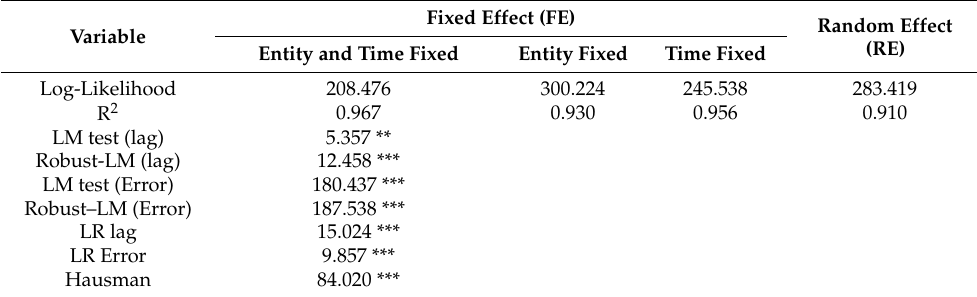
Table 4. DSDM test